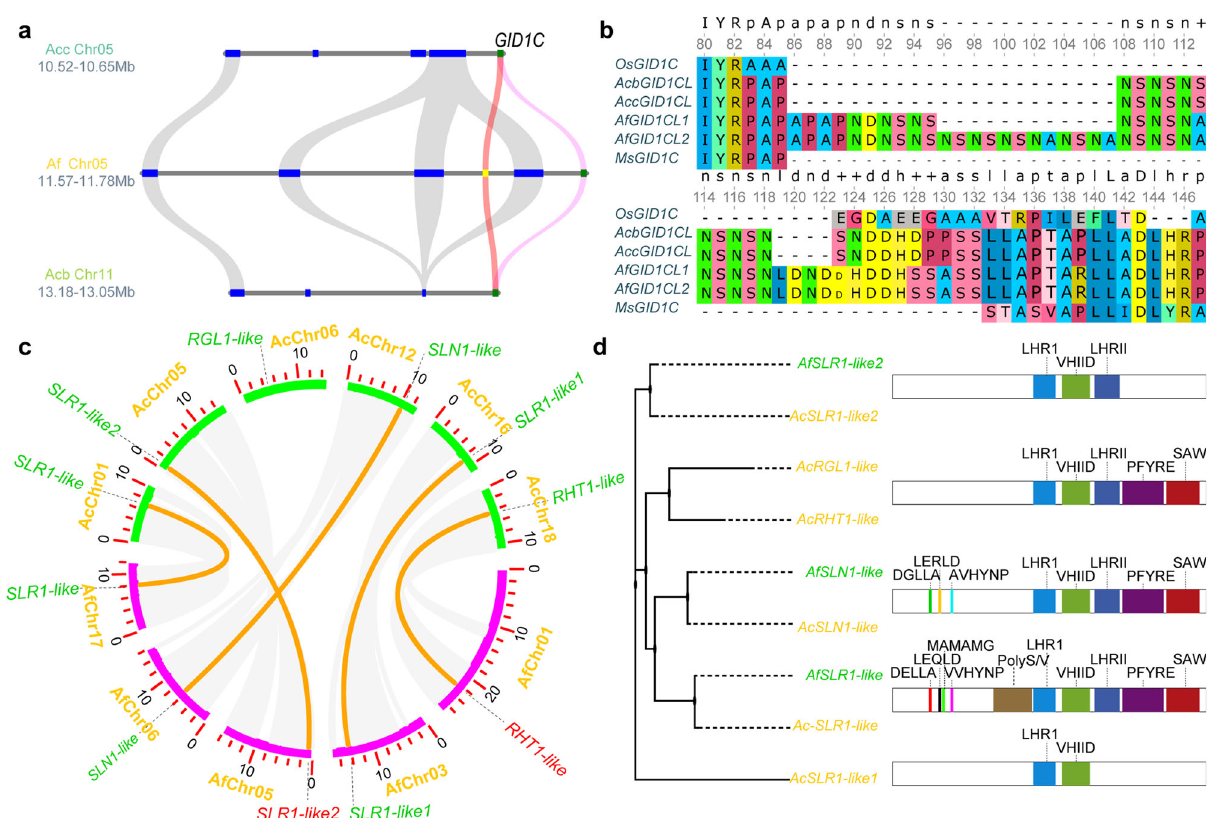
Fig. 4 Duplication of GID1C-like and contraction of DGLLA-like in A. fasciata . a Microsynteny block containing the duplicated GID1-likes among A. fasciata (Af), A. comosus var. comosus (Acc) and A. comosus var. bracteatus (Acb). b Portion of the multiple alignment of GID1C-like proteins; Os, Oryza sativa subsp. Japonica ; Ms, Musa acuminata subsp. malaccensis ; Acb, A. comosus var. bracteatus ; Acc, A. comosus var. comosus ; Af, A. fasciata . c The distribution and synteny of DELLA and DGLLA-like proteins between A. fasciata (Af) and A. comosus var. comosus (Acc). d The domain and polygenetic tree of A. fasciata (Af) and A. comosus var. comosus (Acc) DELLA and DGLLA -like